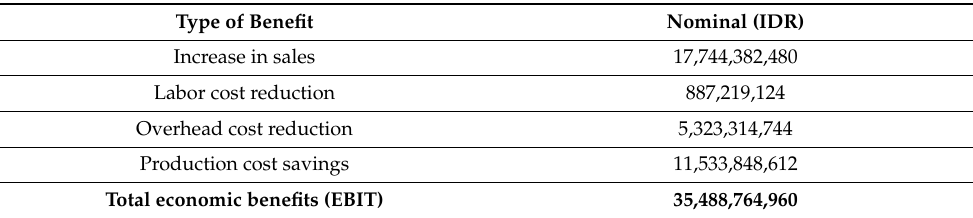
Table 11. Benefits component